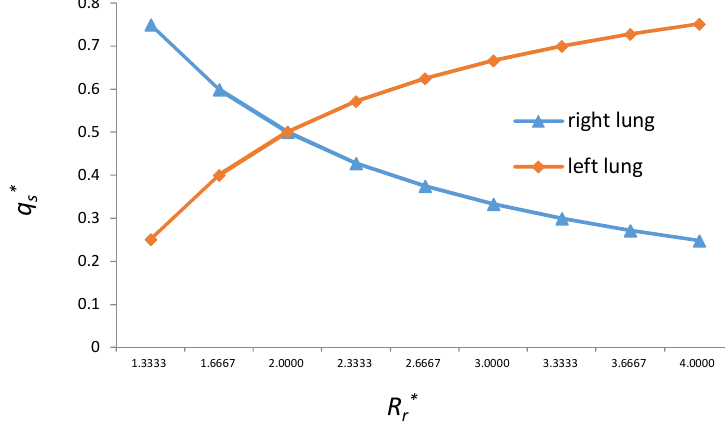
Figure 12. Influence of dimensionless air resistance on dimensionless air mass flow of two lungs.